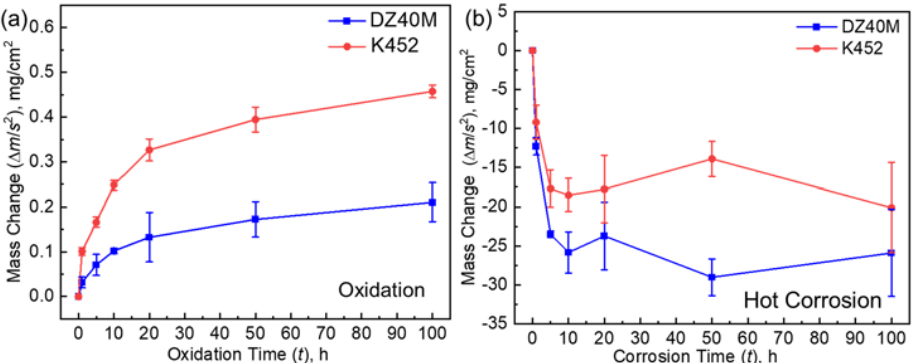
Figure 3. Kinetics curves of DZ40M and K452 at 900 °C. ( a ) High ‐ temperature oxidation in air, and ( b ) hot corrosion with 4 mg/cm 2 deposited. ( b ) hot corrosion with 4 mg/cm 2